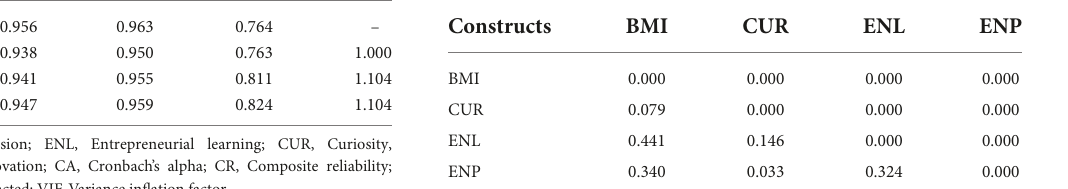
TABLE 5 Discriminant validity (Heterotrait-Monotrait ratio HTMT).